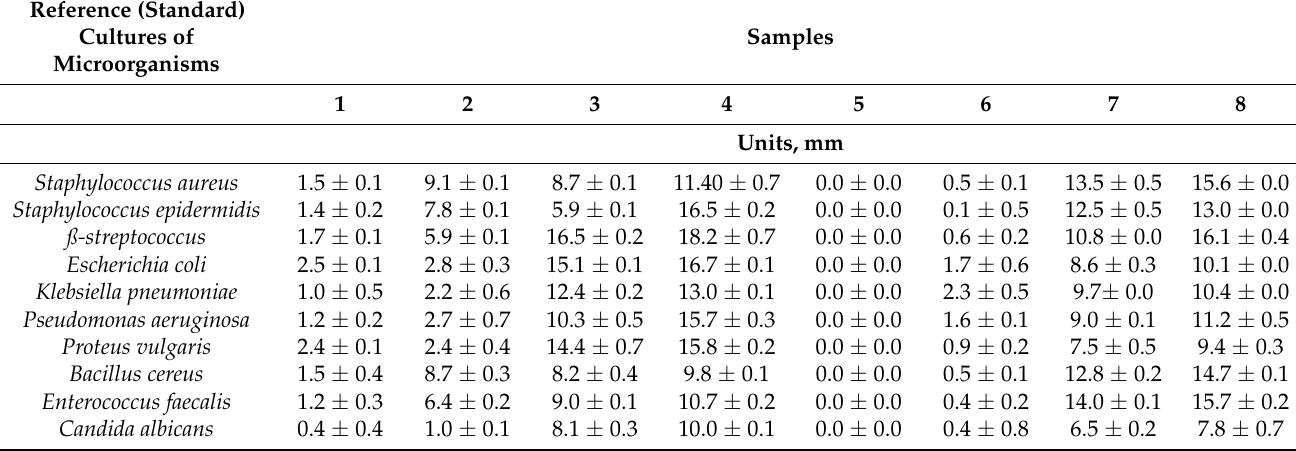
Table 3. Antimicrobial activity of the green synthesized AgNPs.